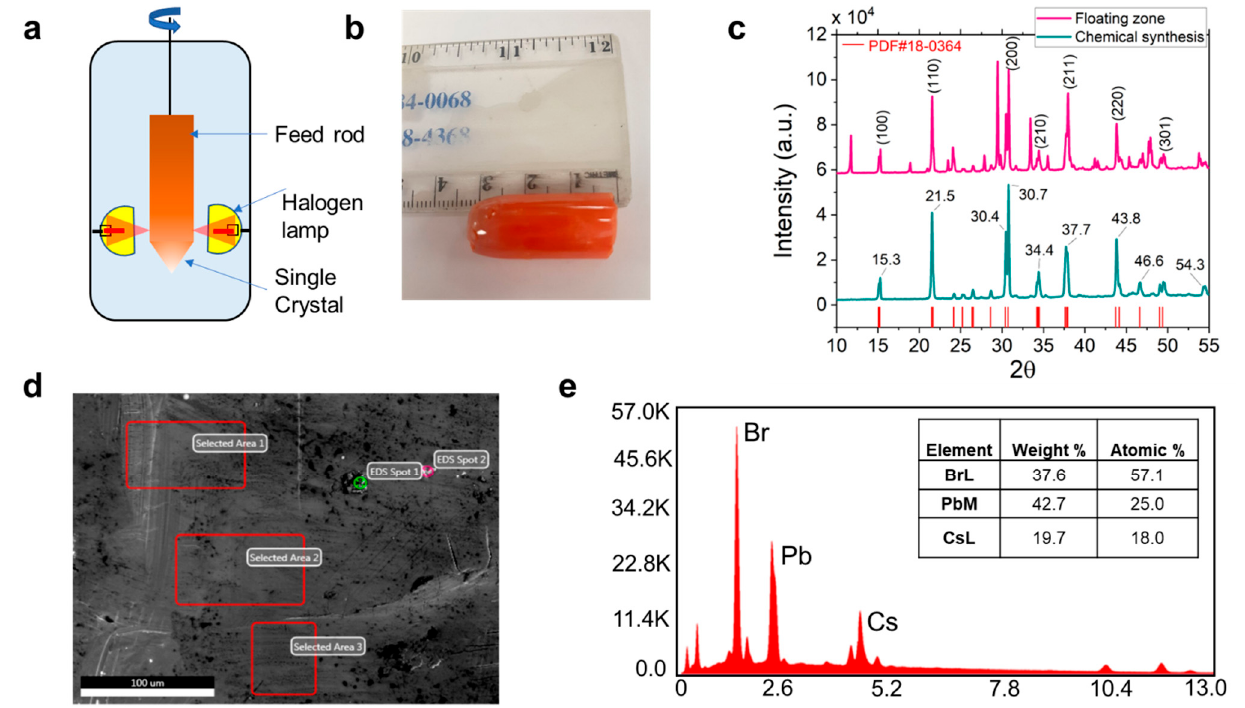
Figure 1. Synthesis of CsPbBr 3 using: ( a ) floating zone method; ( b ) Bright field image of single crystal perovskite, and the corresponding ( c ) X-ray diffraction (XRD) pattern of CsPbBr 3 . An example of the Energy Dispersive X-ray Spectroscopy (EDX) result is shown in ( d ). In addition, the composition of several crystals in different areas (red box) yielded a consistent chemical composition, as shown in ( e ).